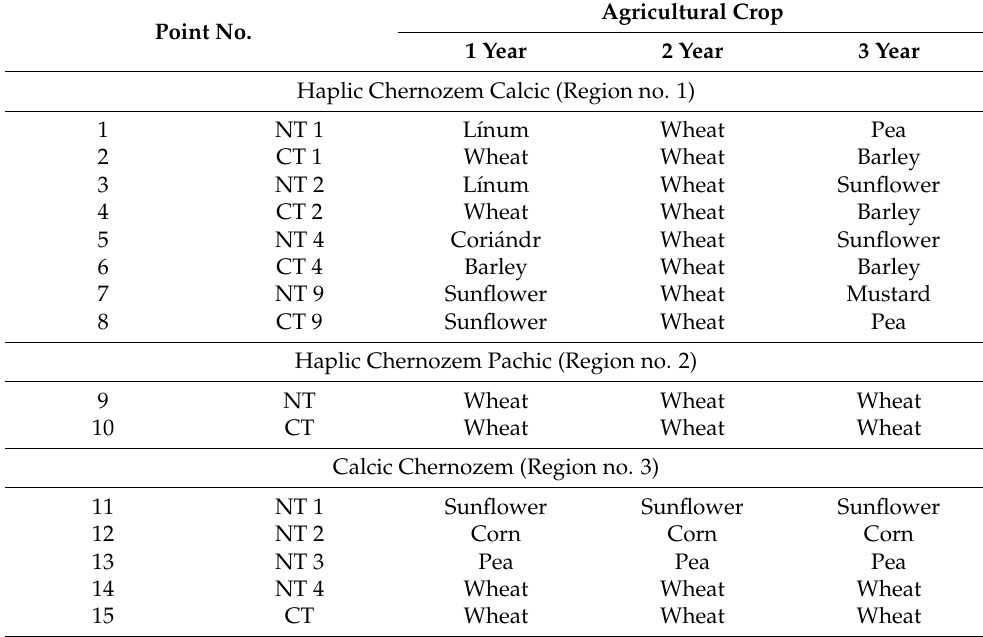
Table 1. Characteristics of soil sampling sites. Point